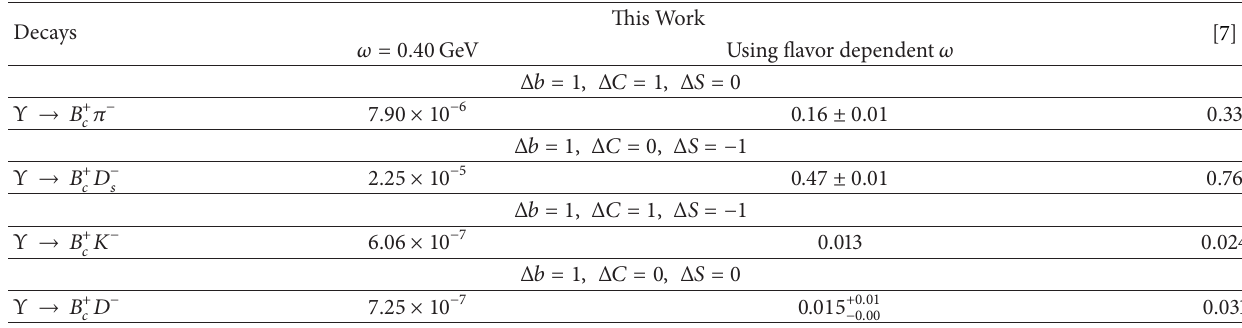
Table 11: Branching ratios (in the units of 10 −10 ) of Υ → 𝐵 𝑐 𝑃 decays.